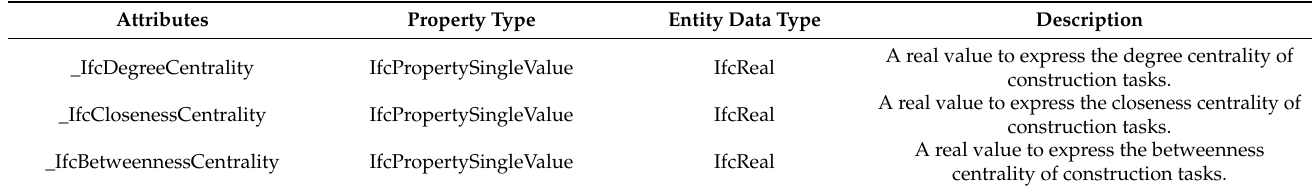
Table 4. Definition of the Pset_